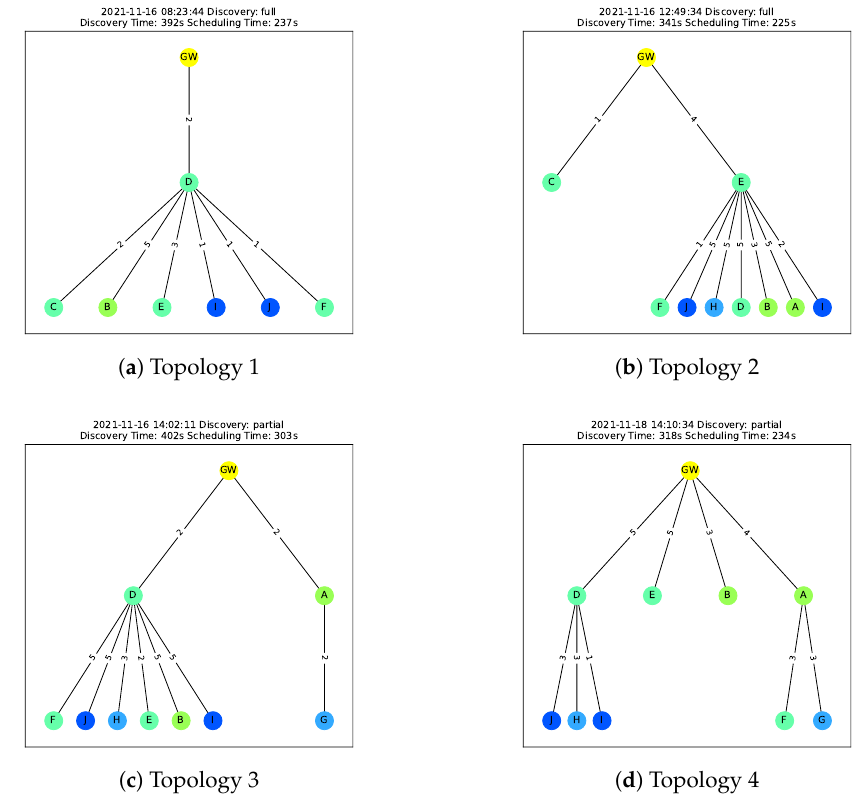
Figure 21. Examples of self-organized network topologies in the North Sea deployment. Each edge displays the Link Quality [integer from 1 to 5] as measured during the discovery process.